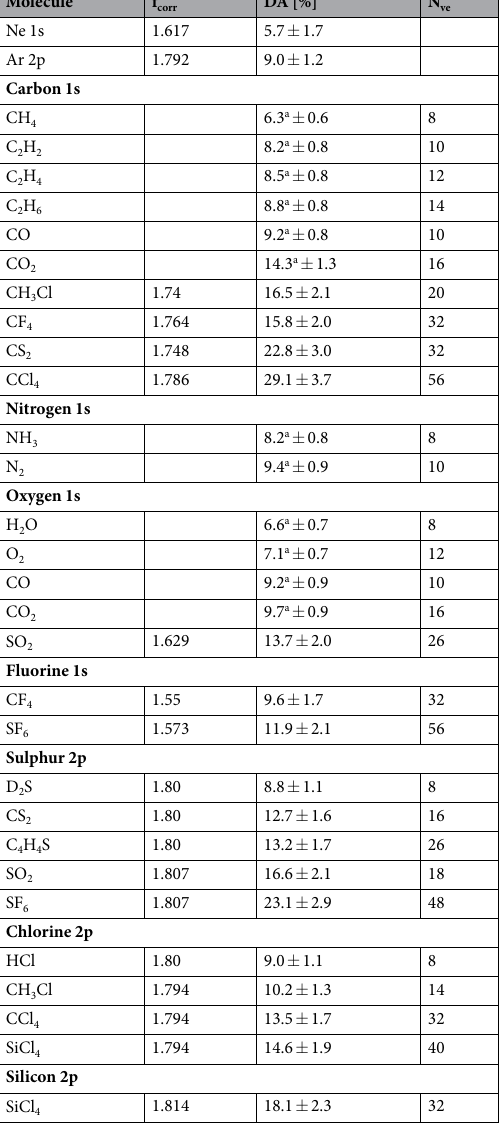
Table 1. Percentage of double to single Auger decay in comparatively simple molecules, their respective correction factor (f corr ), and the number of available valence electrons (N ve ). a Obtained in our previous study in ref. 3